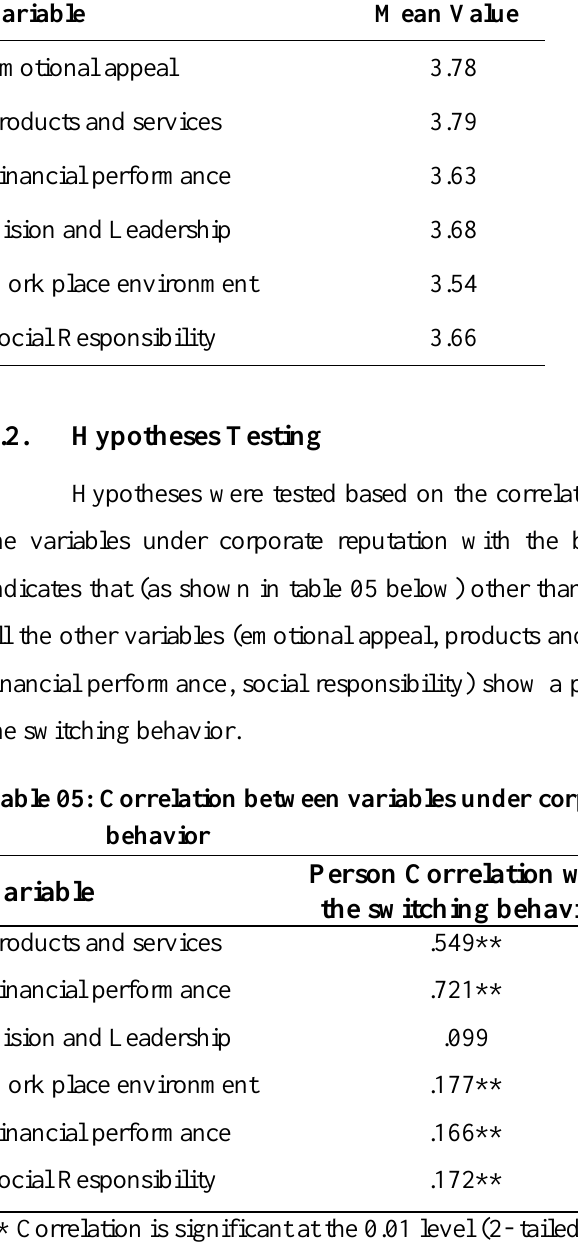
Table 04: The mean value of the variables under reputation quotient Variable